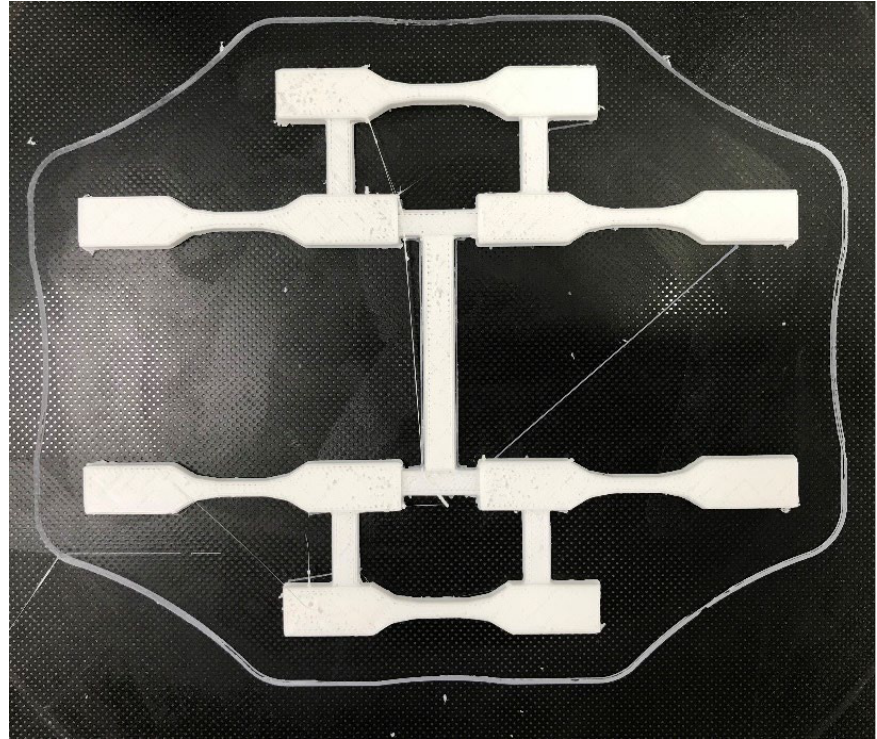
Figure 1. ASTM D638 specimens printed using a 3D printer.